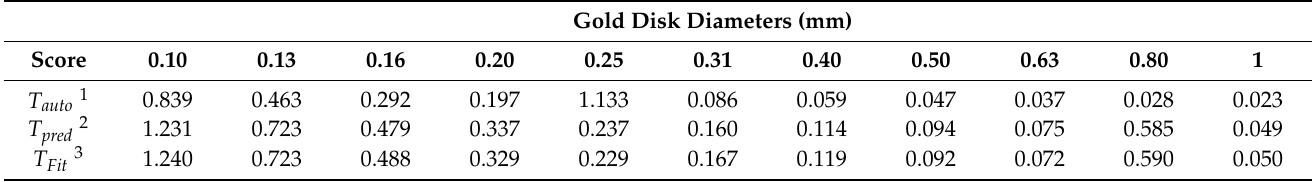
Table 2. Example of the output of the CDMAM3.4 Analyser software: average scores (from all images) in terms of threshold values of thickness (automatic, predicted human and fit-to-predicted Human) for the gold disk diameters.